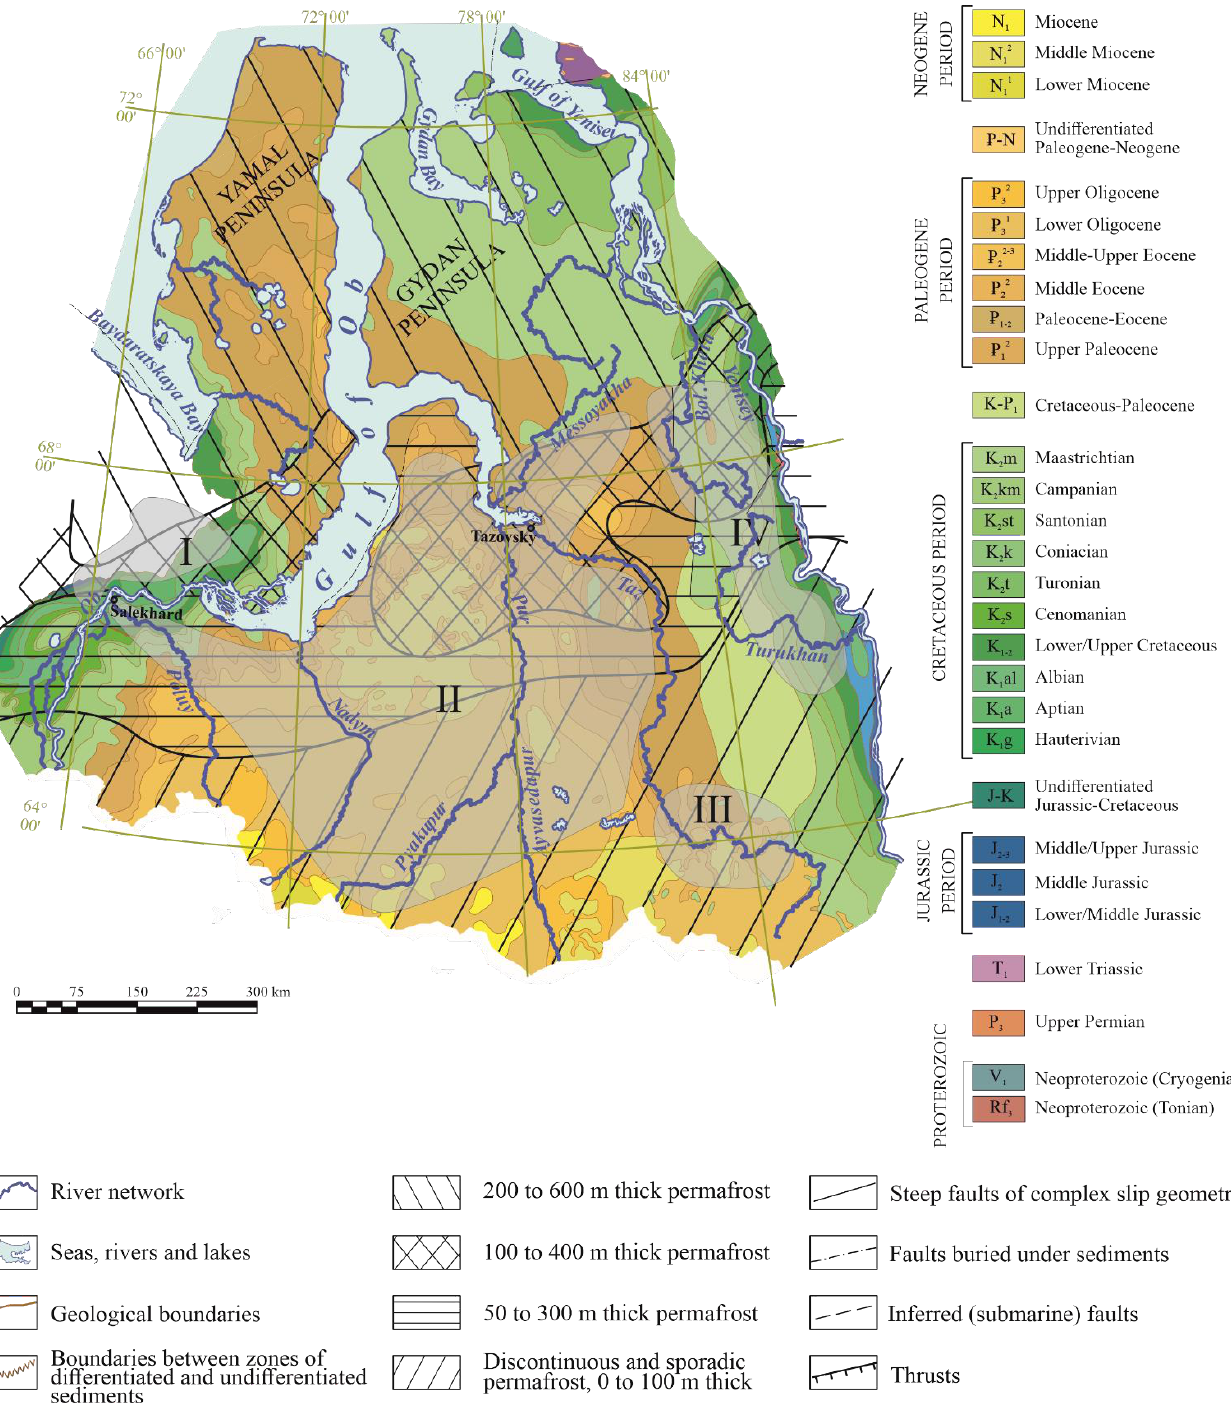
Figure 2. Map of northern West Siberia and local geology [52].